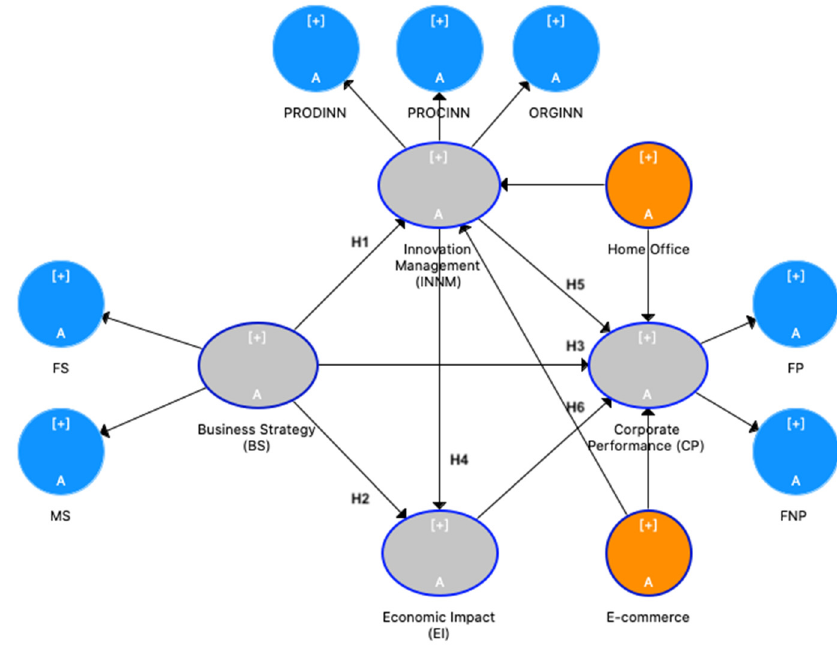
Figure 1. Nomogram of the